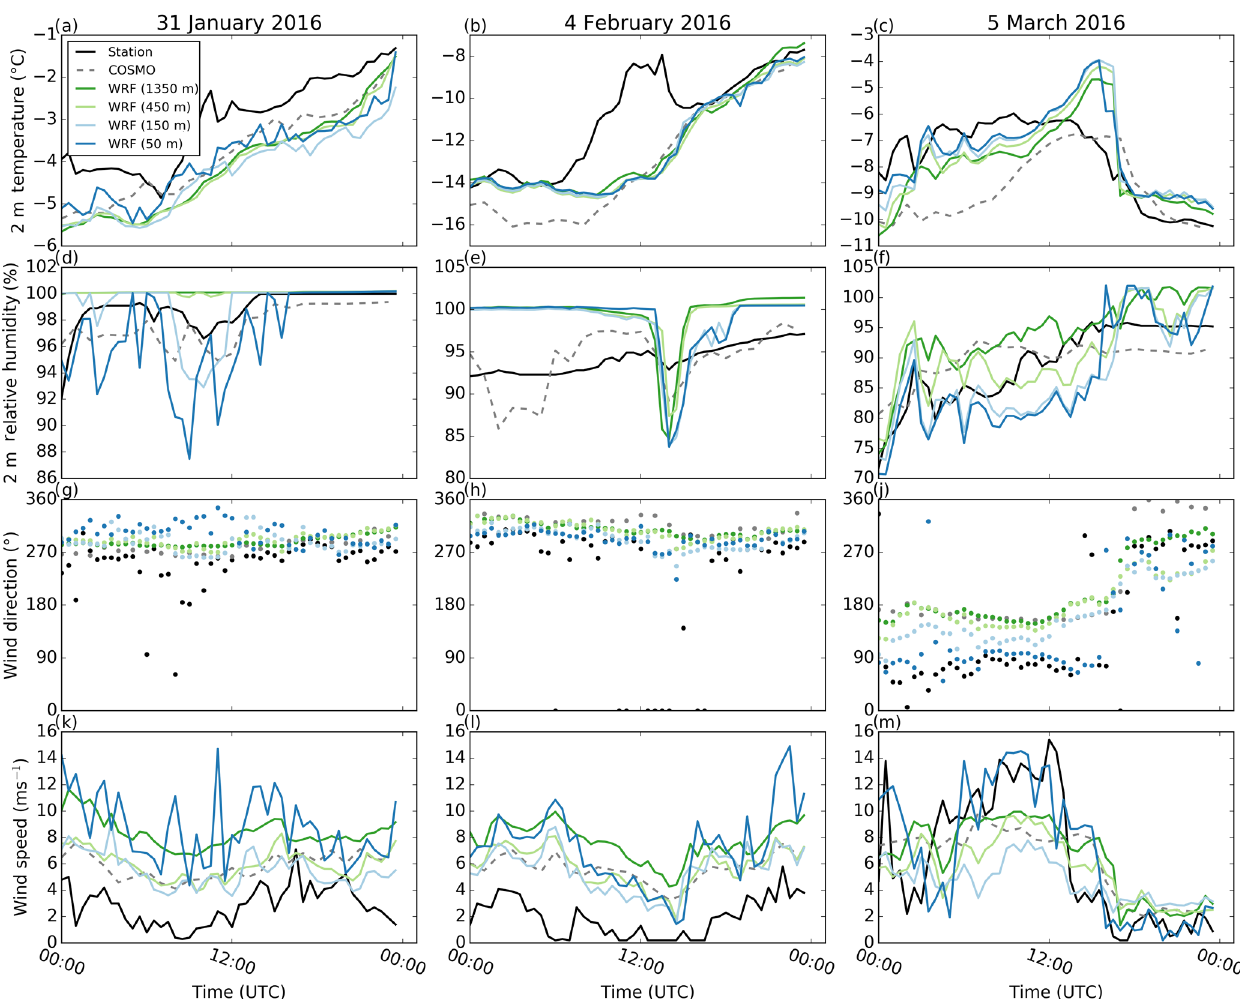
Figure 2. Comparison of (a–c) 2m temperature ( ◦ C), (d–f) 2m relative humidity (%), 4m (g–j) wind direction ( ◦ ) and (k–m) wind speed (ms − 1 ) at the station Dischma Moraine (black) to WRF simulations interpolated to the coordinates of the station Dischma Moraine for the three precipitation events on 31 January, 4 February and 5 March 2016 for all four simulation domains (d01: dark green, d02: light green, d03: light blue, d04: dark blue). For comparison COSMO-2 is added for the closest grid point (dashed gray). The 2m temperature in WRF and COSMO is corrected for elevation based on a moist-adiabatic temperature